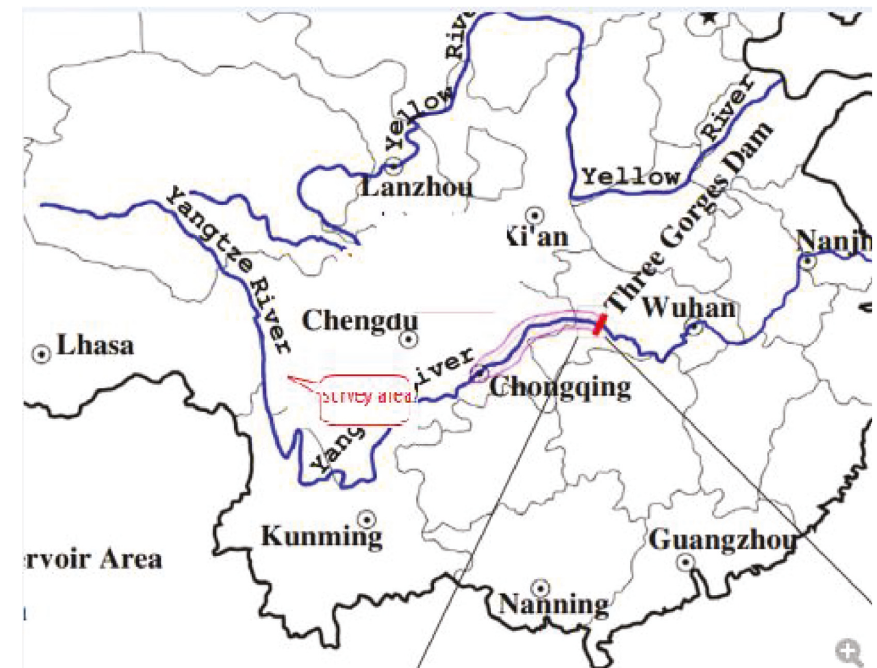
Figure 1: Location of the Jiangbian hydropower station.